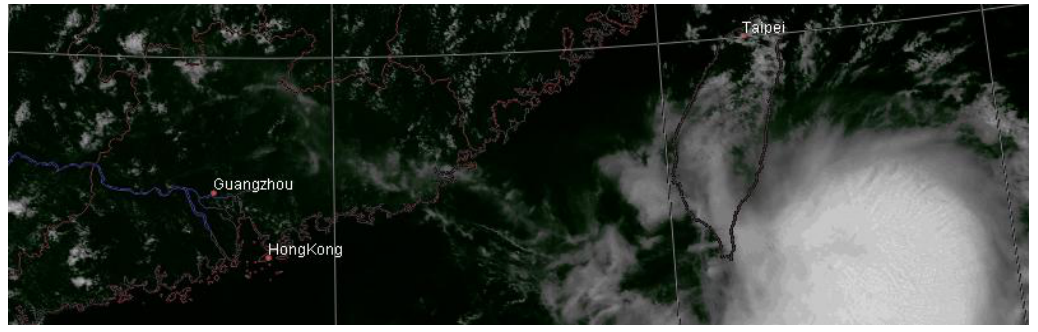
Figure 4. MTSAT images of South China and Taiwan on 1300 LST 24 July 2006. ( a ) VIS image. It fails to capture the peripheral clouds of the cyclone. ( b ) IR image. It presents the peripheral clouds that are absent in (a). ( c ) Fused image. It has higher resolution, and retains the cyclone peripheral clouds as in (b). The red box indicates an area with abnormal temperature. ( d ) Corrected